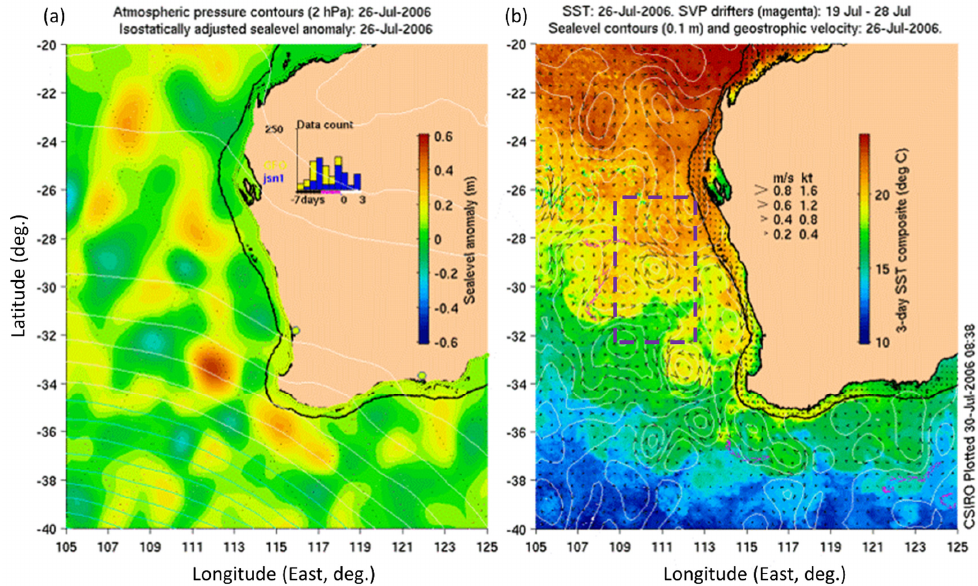
Figure 35. Altimeter map of the eastern Indian Ocean, 26 July 2006 [120]. ( a ) Sea-level anomaly, ( b ) geostrophic velocity. The purple box marks the area selected for detailed modelling, as presented in Figure 36.